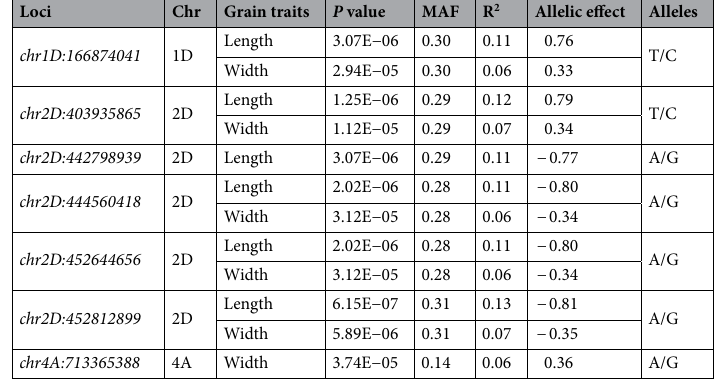
Table 3. Details of loci associated with grain size traits identified via a genome-wide association study in a collection of 157 hexaploid wheat lines. Chr Chromosome, MAF Minor allele frequency, R 2 R square of model with SNP, calculated by R 2 of model with SNP minus R 2 of model without SNP 48